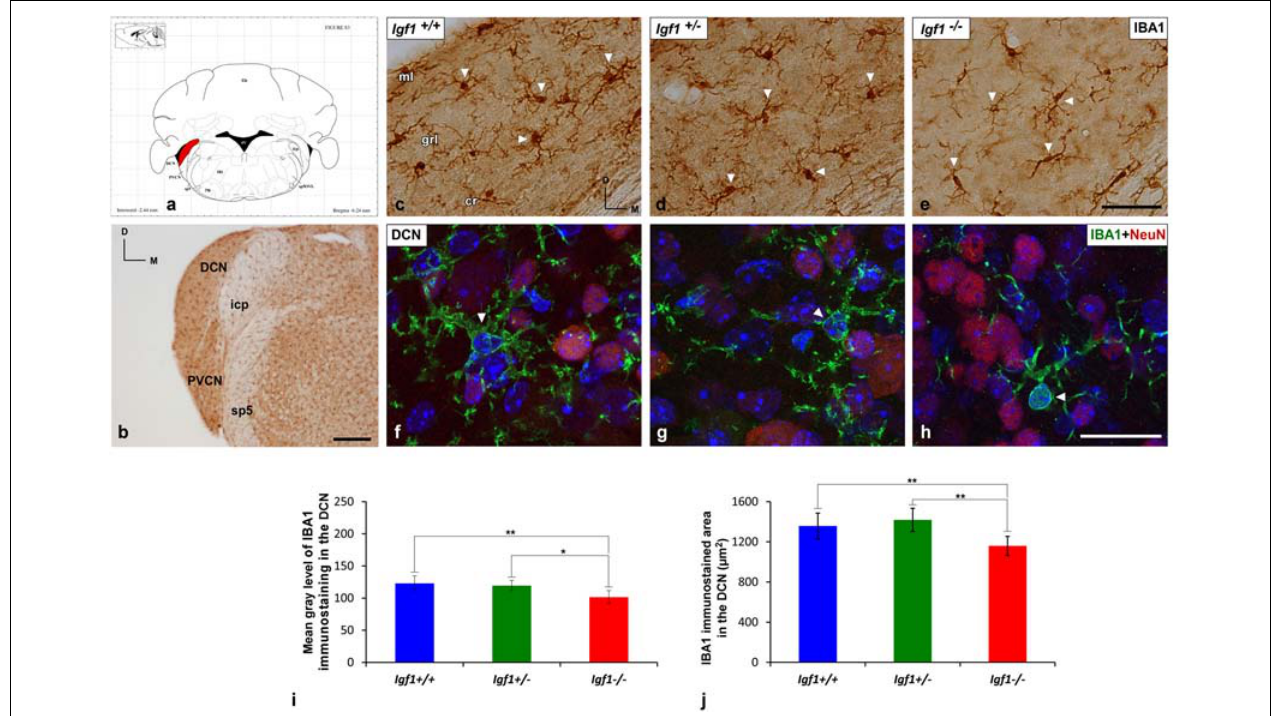
FIGURE 2 | IBA1 immunostaining in the DCN of Igf1 − / − mice. (A) Coronal section of a wild-type mouse brain taken from the Franklin and Paxinos (2013) mouse brain atlas, to show the location of the DCN (red) and PVCN. (B) Representative coronal section of the cochlear nuclei in the wild-type genotype immunostained with IBA1. In Igf1 − / − mice, cells with multipolar or bipolar morphology were stained more weakly, and they had shorter processes than in Igf1 + / + and Igf1 + / − mice (arrows in C–E ). The maximum intensity projections of confocal images of the DCN illustrate a reduction in microglial branching in Igf1 − / − mice (arrow in H ) when compared to the other genotypes (arrows in F , G ). Quantification of the immunostaining showed the significant decrease in the mean gray levels (I) and the immunostained areas (J) in the Igf1 − / − mouse when compared to the other genotypes. Arrows point to IBA1 immunostained cells. Cell nuclei in (F–H) are stained with DAPI (blue). The error bars indicate the standard deviations of the mean. Statistically significant differences among the animal groups were evaluated by one-factor analyses of variance (ANOVA; ∗ p < 0.05; ∗∗ p < 0.01). Abbreviations: Cb, Cerebellum; cr, central region of the dorsal cochlear nucleus (DCN); grl, granule/fusiform layer; IBA1, ionized-calcium-binding adaptor; icp, inferior cerebellar peduncle; IRt, intermediate reticular nucleus; ml, molecular layer; NeuN, neuronal marker; PVCN, posteroventral cochlear nucleus; sp5, spinal trigeminal nucleus; sp5OVL, spinal trigeminal nucleus, oral part, ventrolateral division; 4V, 4th ventricle; 7N, facial nucleus. Scale bars: 250 µ m in (B) ; 50 µ m in ( C ; it also applies to C , D ); 20 µ m in ( H ; it also applies to F , G ).